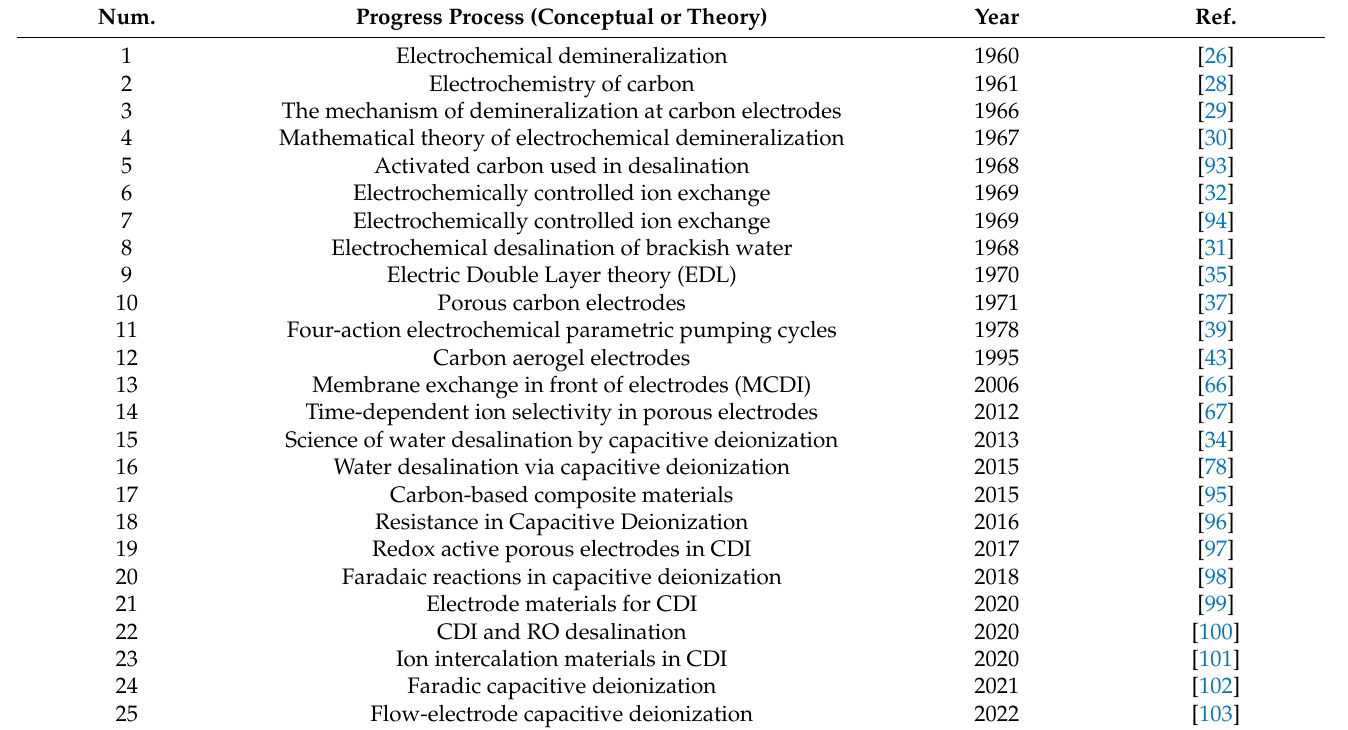
Table 1. The progress of theoretical and conceptual development in CDI systems for water desalination.